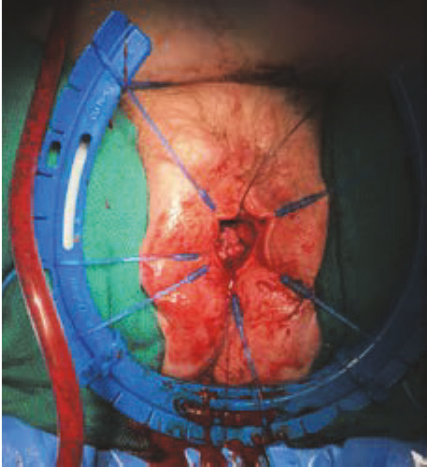
Figure 2: Thebladder neckclosureis seen with both the interrupted and imbricating layer of 2-0 vicryl closed.